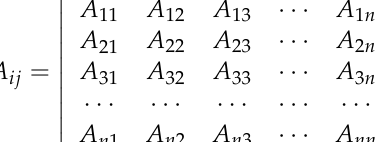
Table 1. Reclassification of LULC type according to the RCMRD classification system. LULC Type after Reclassification Forest Dense Forest Grassland Closed Grassland Cropland Perennial Cropland Wetland Wetland Water Water Body Urban Settlement Unused